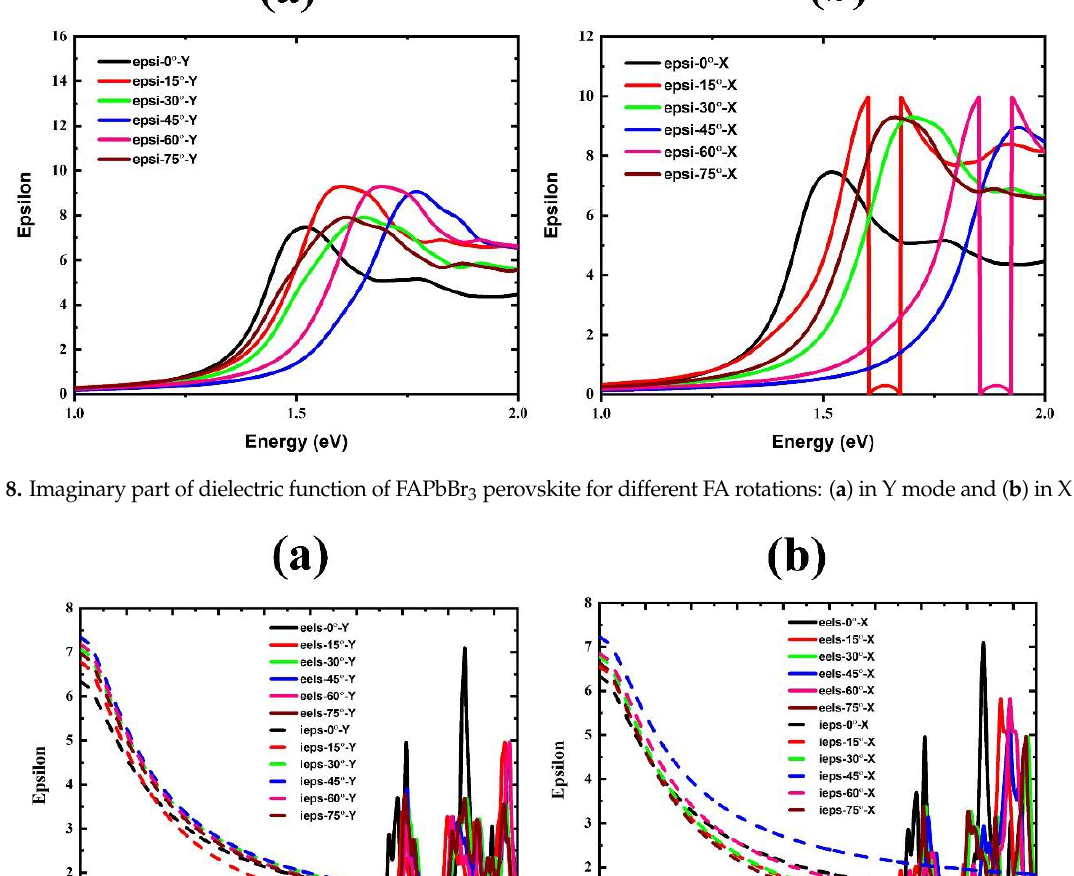
Figure 9. Electron energy loss and ε ( i ω ) spectra of FAPbBr 3 perovskite for different FA rotations: ( a ) in Y mode and ( b ) in X mode. Table 3. Wavelength of absorption edge and static dielectric constants of FAPbBr 3 perovskite for all rotational modes.